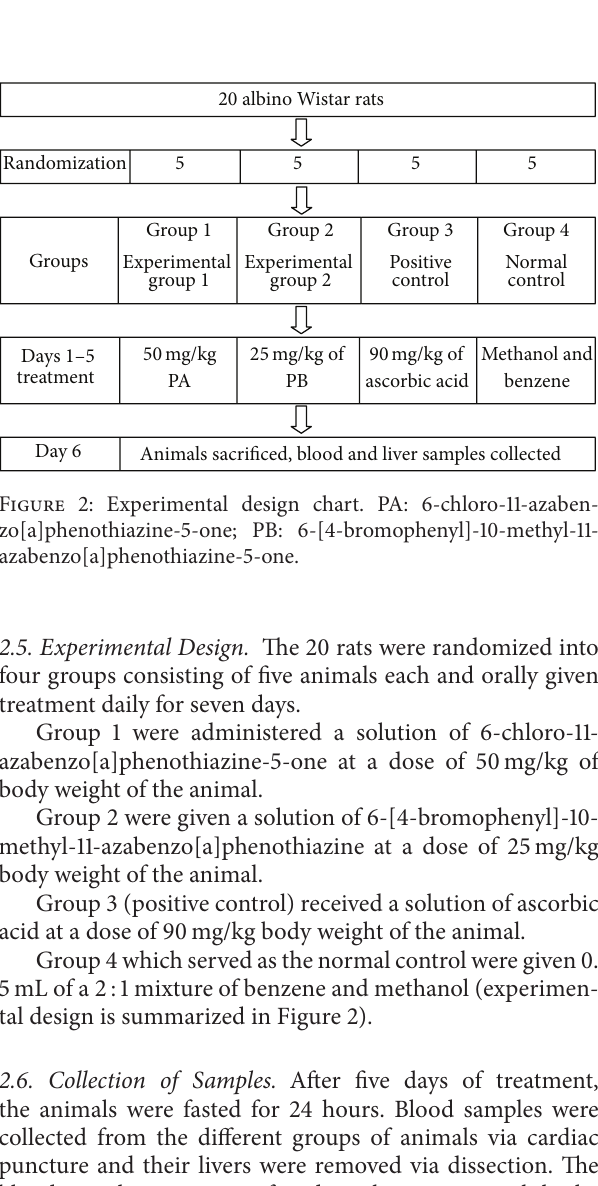
Figure 1: Phenothiazine derivatives. PA: 6-chloro-11-azabenzo[a]phenothiazine-5-one; PB: 6-[4-bromophenyl]-10-methyl-11-azabenzo[a] phenothiazine-5-one.